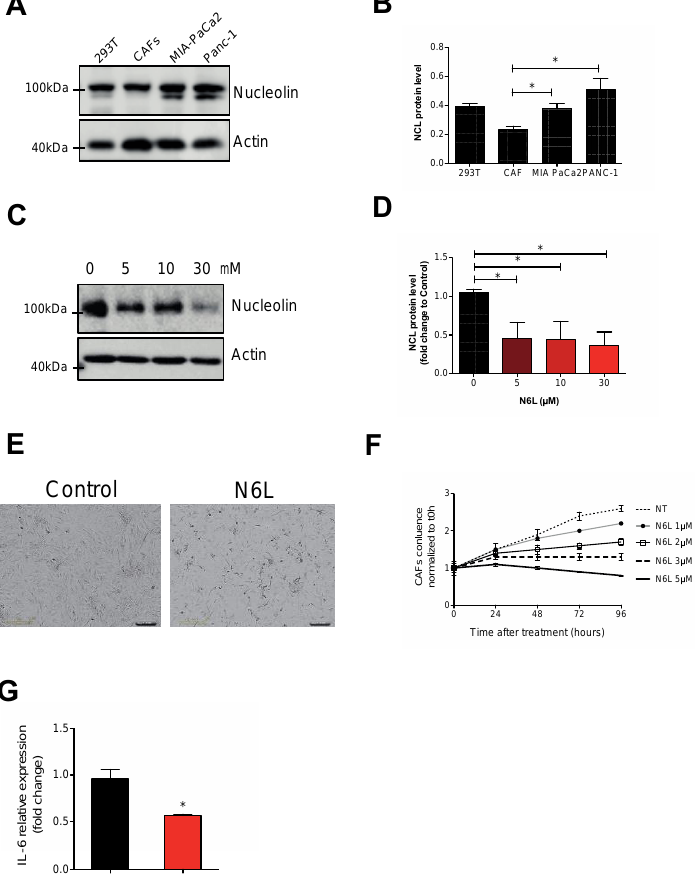
Figure 5. N6L regulates CAF viability and IL-6 expression. ( A ) Immunoblot analysis of nucleolin in cell lysates from HEK293T (293T), human immortalized CAFs, MIA PaCa-2, and PANC-1 cells or ( C ) of nucleolin in CAFs treated or not with N6L (5, 10, or 30 µ M) for 24 h. β -Actin was used as loading control. Nucleolin protein level of Western blots was analysed, and the ratio of nucleolin/ β -actin intensity in different cell lines is shown in ( B ) or after N6L treatment as fold change to untreated cells 0 ( D ). ( C , D ) CAFs were treated by increasing concentrations of N6L (1, 2, 3, and 5 µ M), and cell growth was assessed by Incucyte ® live-cell imaging over 96 h. Representative pictures of 5 µ M N6L and control are shown in C . Scale bar: 100 µ m. ( D ) CAF confluence (%) was calculated with Incucyte ® software and normalized to non-treated cells. ( E , F ) IL-6 relative expression analysis in CAFs non-treated or treated with N6L 5 µ M for 72 h. mRNA levels were normalized to GAPDH. For ( B , D , G ) (two-tailed Mann-Whitney t-test, *, p < 0.05, n = 3 experiments).Uncropped WB images were shown in Figure S4.